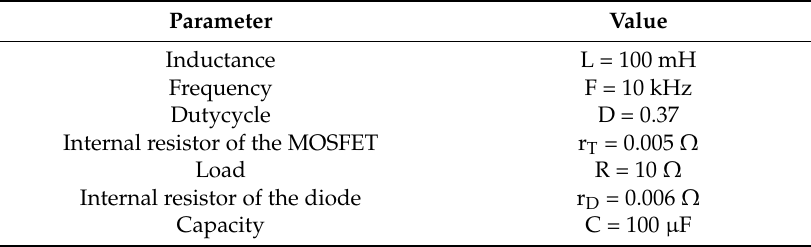
Table 4. The parameters of the DC/DC converter and